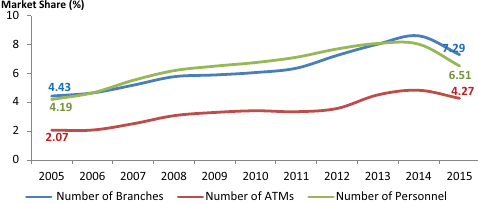
Figure 6. IBs Market shares